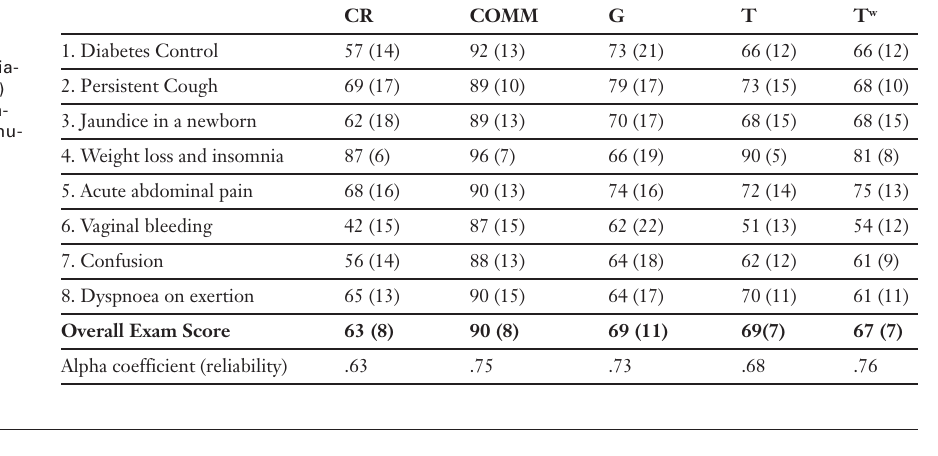
Pearson correlation coefficients between the CR component scores (n =